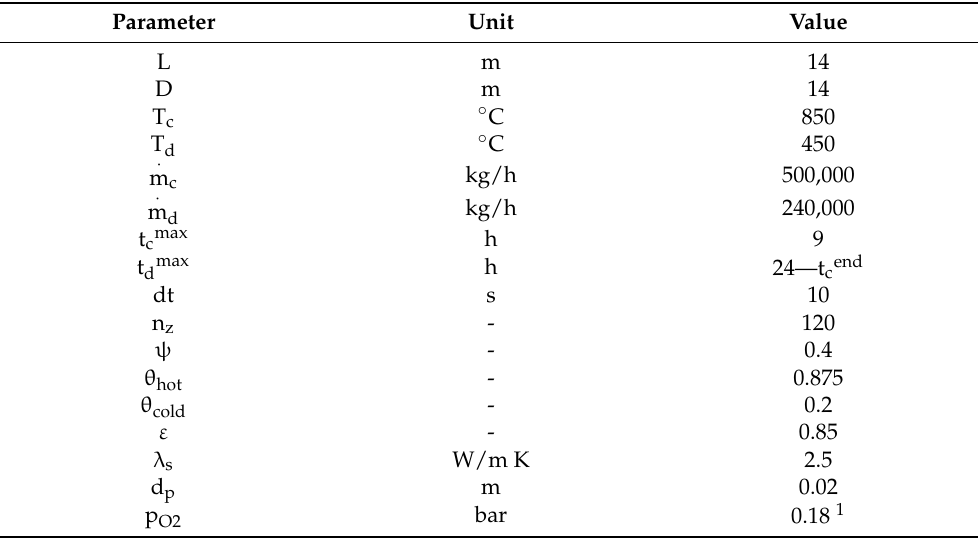
Table 2. Packed bed TES numeric simulation parameters. Subscripts c and d stand for charging and discharging,